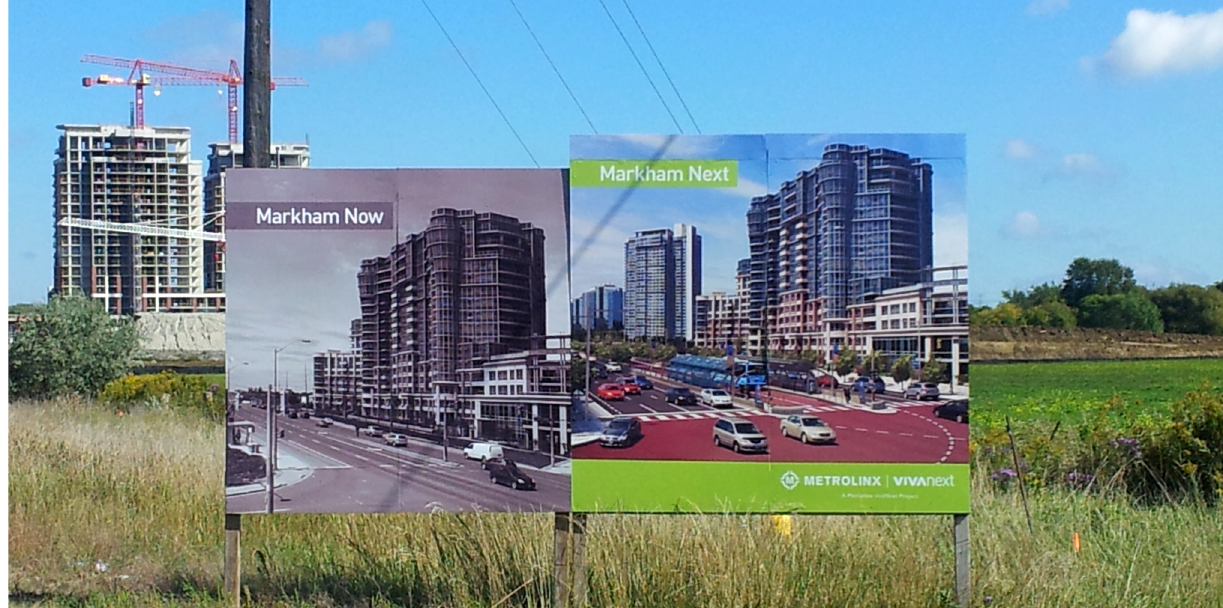
Figure 7. Bus rapid transitway public awareness campaign ‘Markham Now; Markham Next.’ Source: